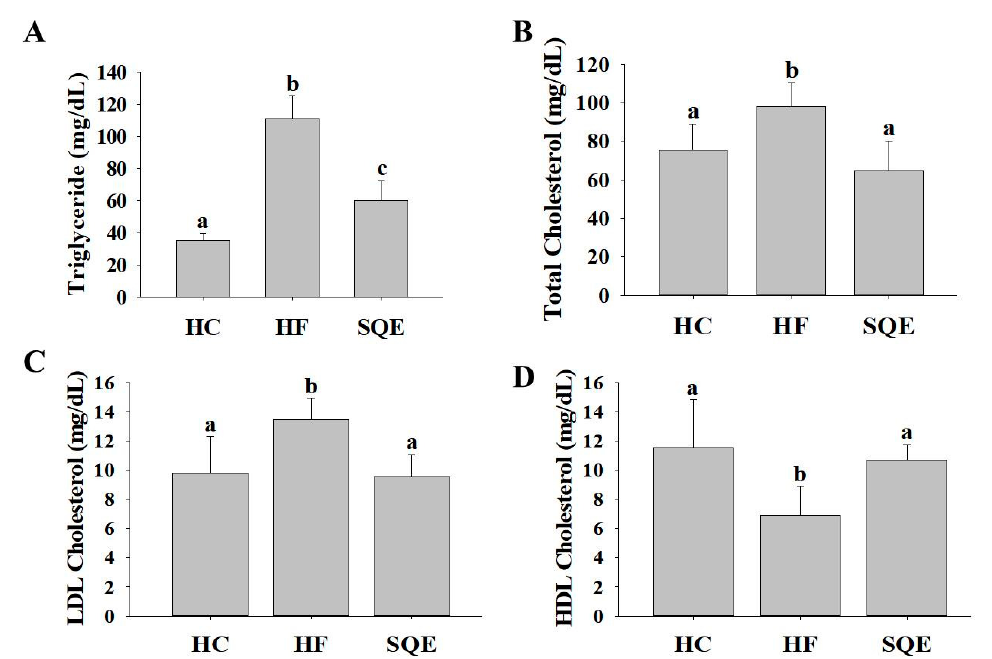
Figure 1. Effect of SQE supplementation on serum lipid levels in HF-diet-fed rats: ( A ) Serum triglyceride levels; ( B ) total cholesterol levels; ( C ) LDL-cholesterol levels; ( D ) HDL-cholesterol levels. Data are given as mean ± SD ( n = 7). Different letters in each assay indicate significant differences among the HC, HF, and SQE groups by Tukey’s multiple range test ( p < 0.05). HC, 46% carbohydrate diet; HF, 60% fructose diet; SQE, 60% fructose diet with SQE (500 mg/kg of BW) in drinking water. BW, body weight; HC, high-carbohydrate-diet-fed rats; HF, high-fructose-diet-fed rats; SQE: the high-fructose-diet-fed rats supplemented with S. quelpaertensis leaf extract; LDL-C, low-density lipoprotein cholesterol; HDL-C, high-density lipoprotein cholesterol, BW, body weight.